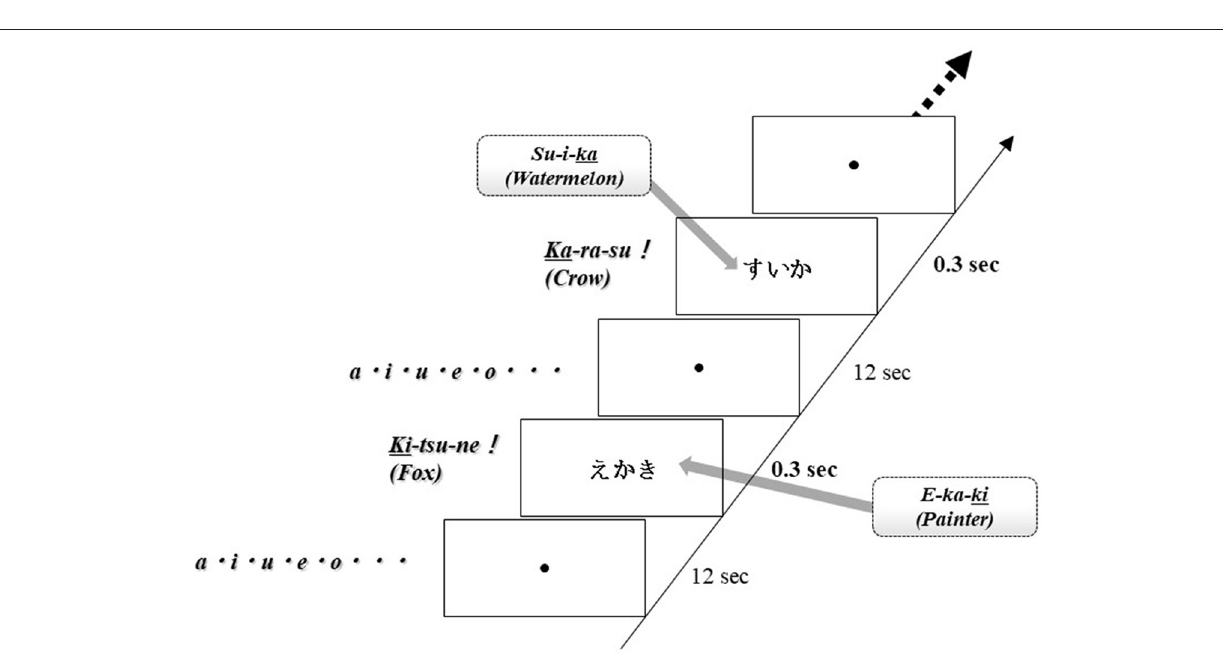
1 oxy-Hb revealed a significant negative correlation with HAM- D score at left ch.22 ( r = − 0.55, p = 0.0033) and right ch.19 ( r = − 0.59, p = 0.0013) for patients with MDD ( Figure 4 ).